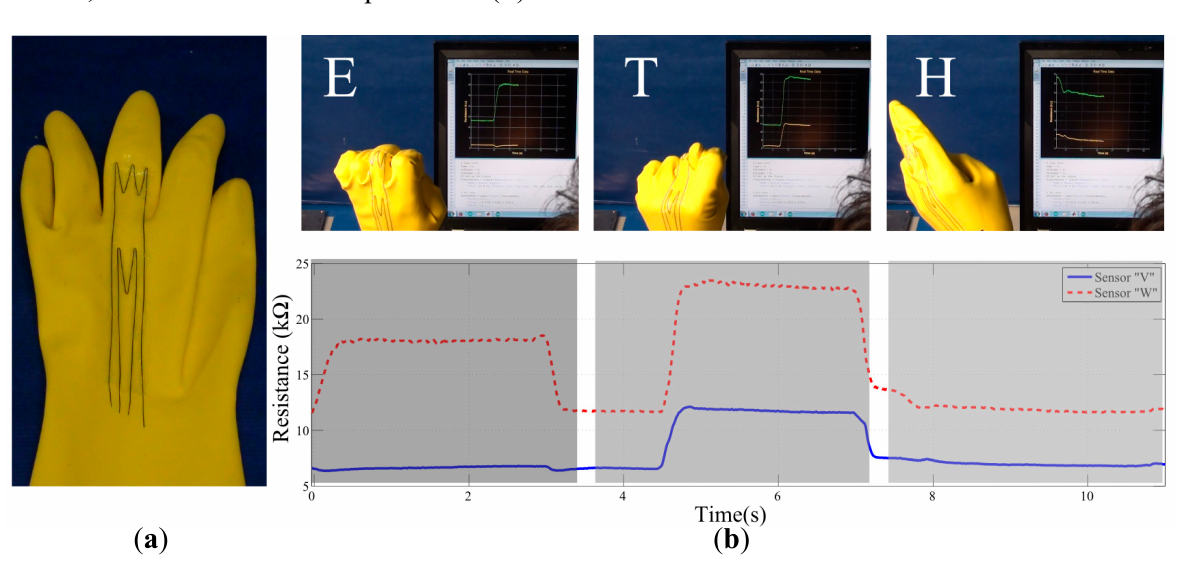
Figure 9. Experiments with CTPE sensors attached on plastic gloves to detect complex hand postures ( a ); In our case, American hand sign language is used to discriminate letters “E”, “T” and “H” in the experiments ( b